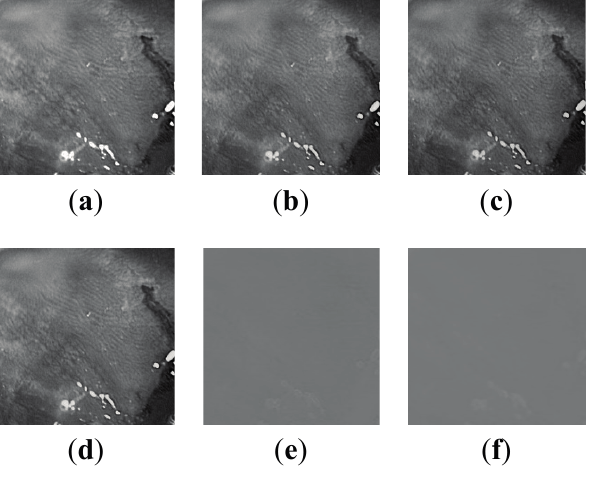
Figure 5. Intensity distribution of color components of an NBI image: ( a ) R, entropy: 6.80; ( b ) G, entropy: 6.73; ( c ) B, entropy: 6.68; ( d ) Y, entropy: 6.73; ( e ) E, entropy: 2.14; ( f ) F, entropy: